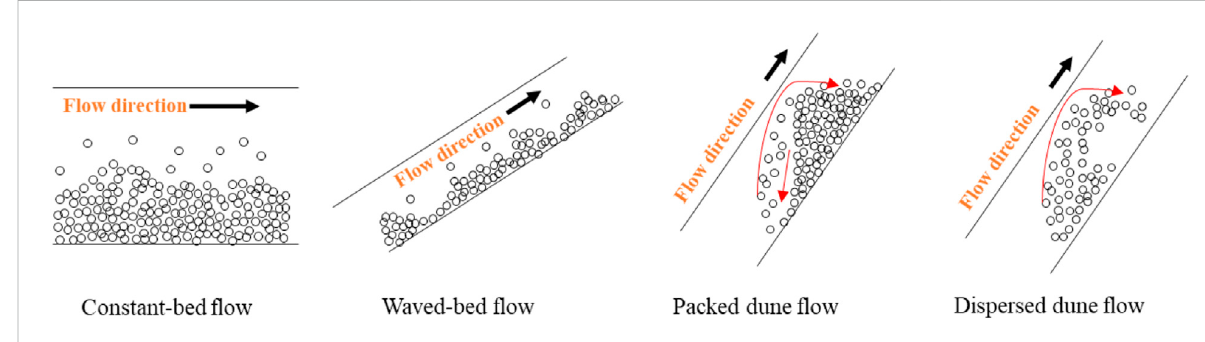
FIGURE 2 Cuttings fl ow patterns for the entire inclination range (Zhang et al., 2015).